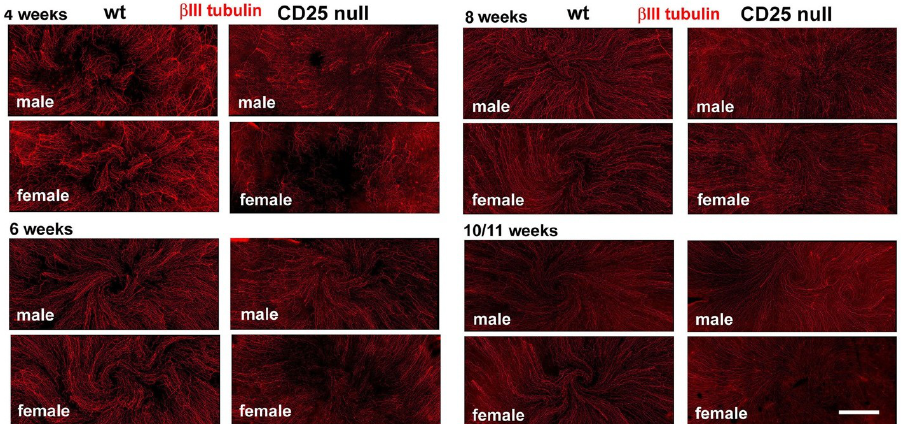
Figure 1. Intraepithelial corneal nerves (ICNs) in male and female wt and CD25 null corneas during early corneal maturation. Shown are representative confocal images from wt land CD25 null male and female corneas obtained, as described in the methods section at 4, 6, 8, and 10/11 wk after staining with antibodies against β III tubulin. Bar = 500 µ